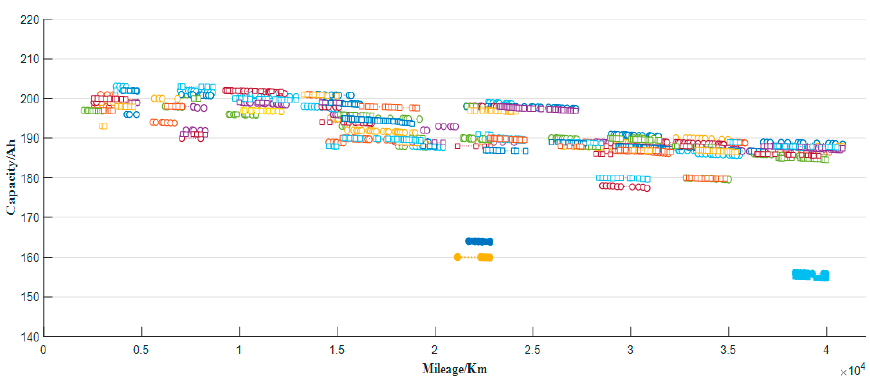
Figure 9. FL + KF capacity estimation result.